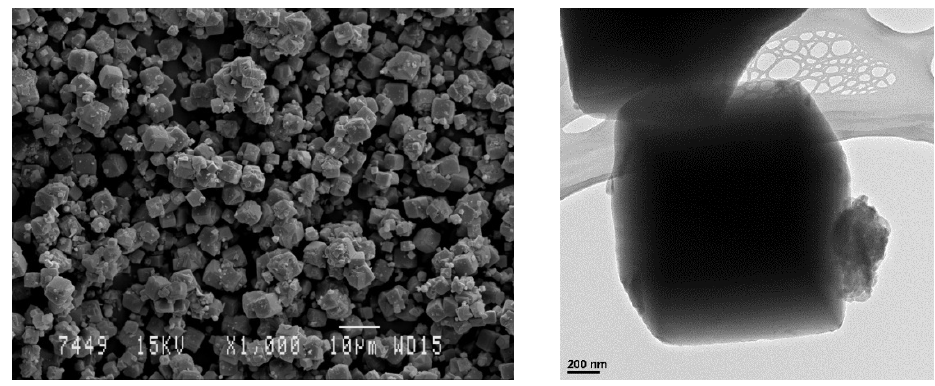
Figure 3. Zeiolite SEM ( left ) and TEM ( right ).